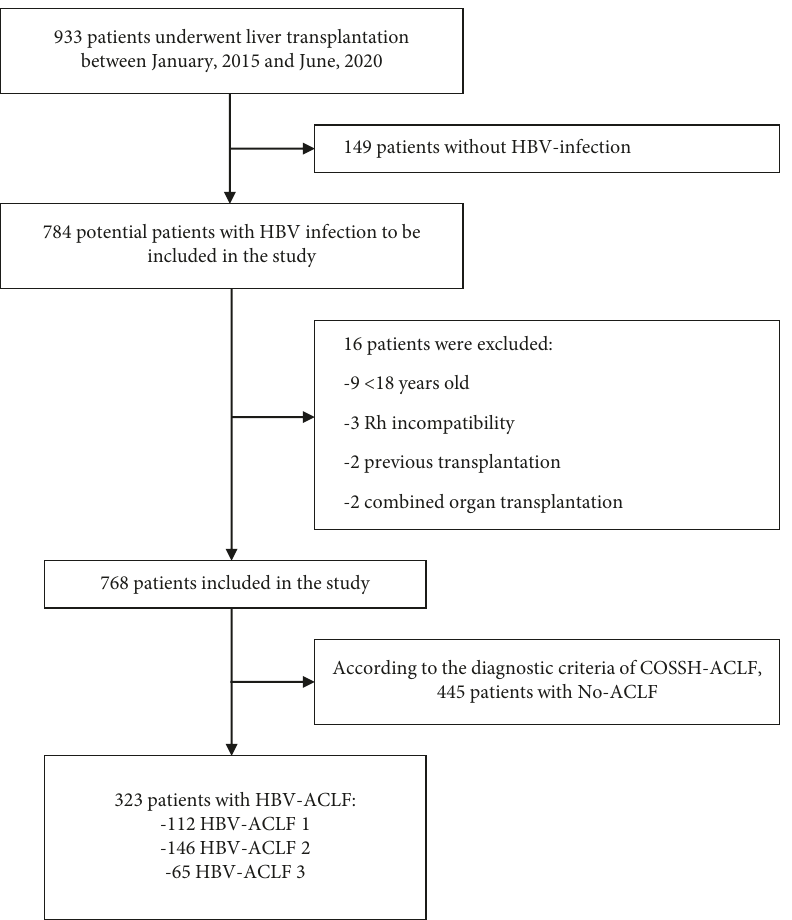
Figure 1: Flow chart of the patients included in this